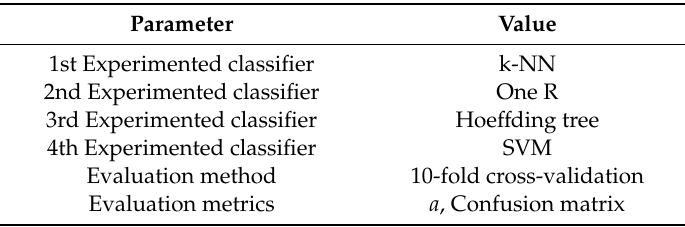
Table 2. Experimental setup parameters and